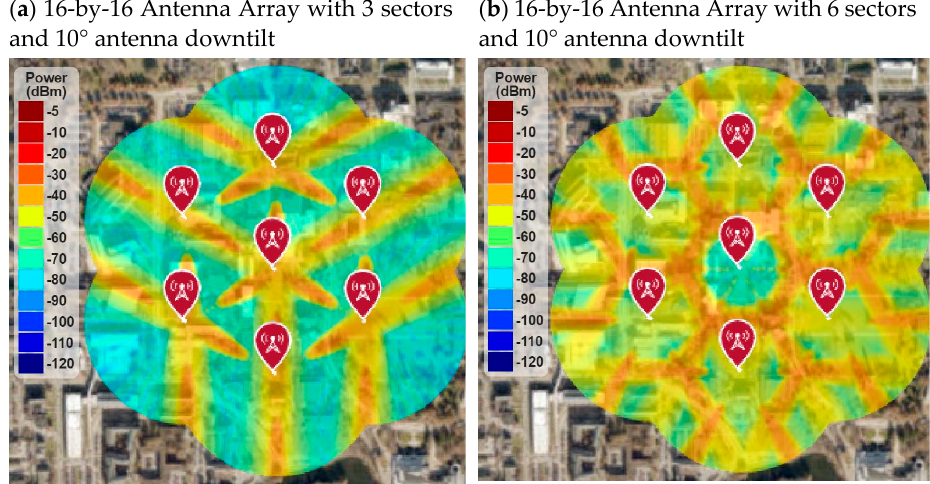
Figure 24. RF coverage and signal strength versus antenna downtilt angle.